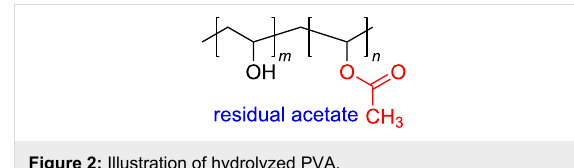
Figure 2: Illustration of hydrolyzed